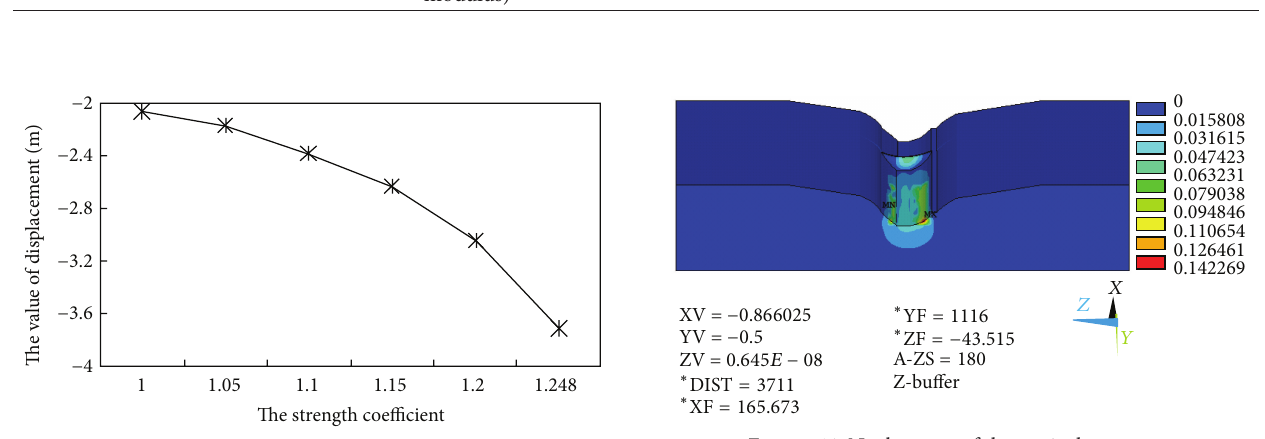
Figure 14: Nephogram of the equivalent stress.